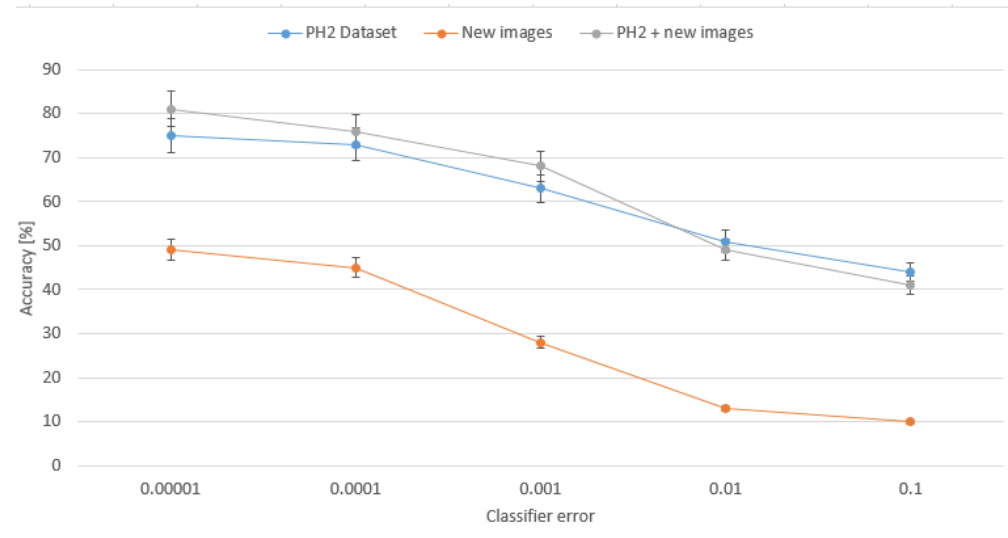
Figure 10. Dependency between the classifier’s error and the average accuracy presented for different assumed error in the classifier for all three configurations of the input data collection.